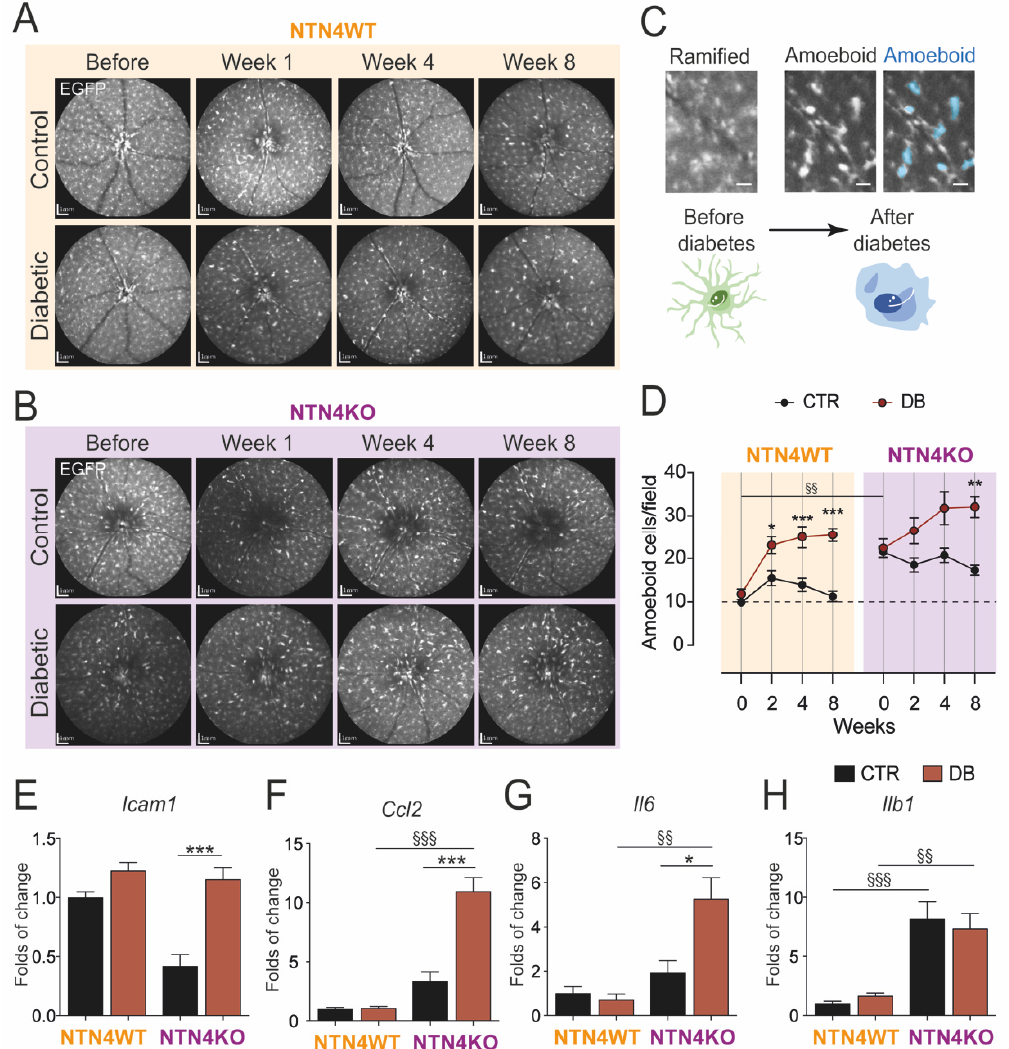
Figure 2. Netrin-4 modulates inflammation in the retina during diabetes. ( A , B ) Representative scanning laser ophthal- moscope images of one animal from either NTN4WT ( A ) or NTN4KO ( B ) during the time-course of diabetes ( n = 10–13 animals per group) ( C ) Representative illustration of ramified mononuclear phagocytes (EGFP-positive) in the retina and their turnover to amoeboid after diabetes induction (indicated in blue in the right panel). Scale bar = 200 µ m Schematic cells represent the turnover. ( D ) Quantification of amoeboid cells per field during the time-course of diabetes in the distinct studied groups. ( E – H ). Bar charts represent mRNA folds of expression to NTN4WT control. Target gene expression of Icam1 ( E ), Ccl2 ( F ), Il6 ( G ), and Il1b ( H ) was normalized to Ywhaz expression ( n = 4–8 animals per group). The asterisk stands for significant p -values when compared to intra-strain control (* = p < 0.05; ** = p < 0.01; *** = p < 0.001 using Student t -test) whereas § stands for significant p -values when comparison was made between mouse strains (§§ = p < 0.01; §§§ = p < 0.001 using 1-way ANOVA). CTR, control. DB,